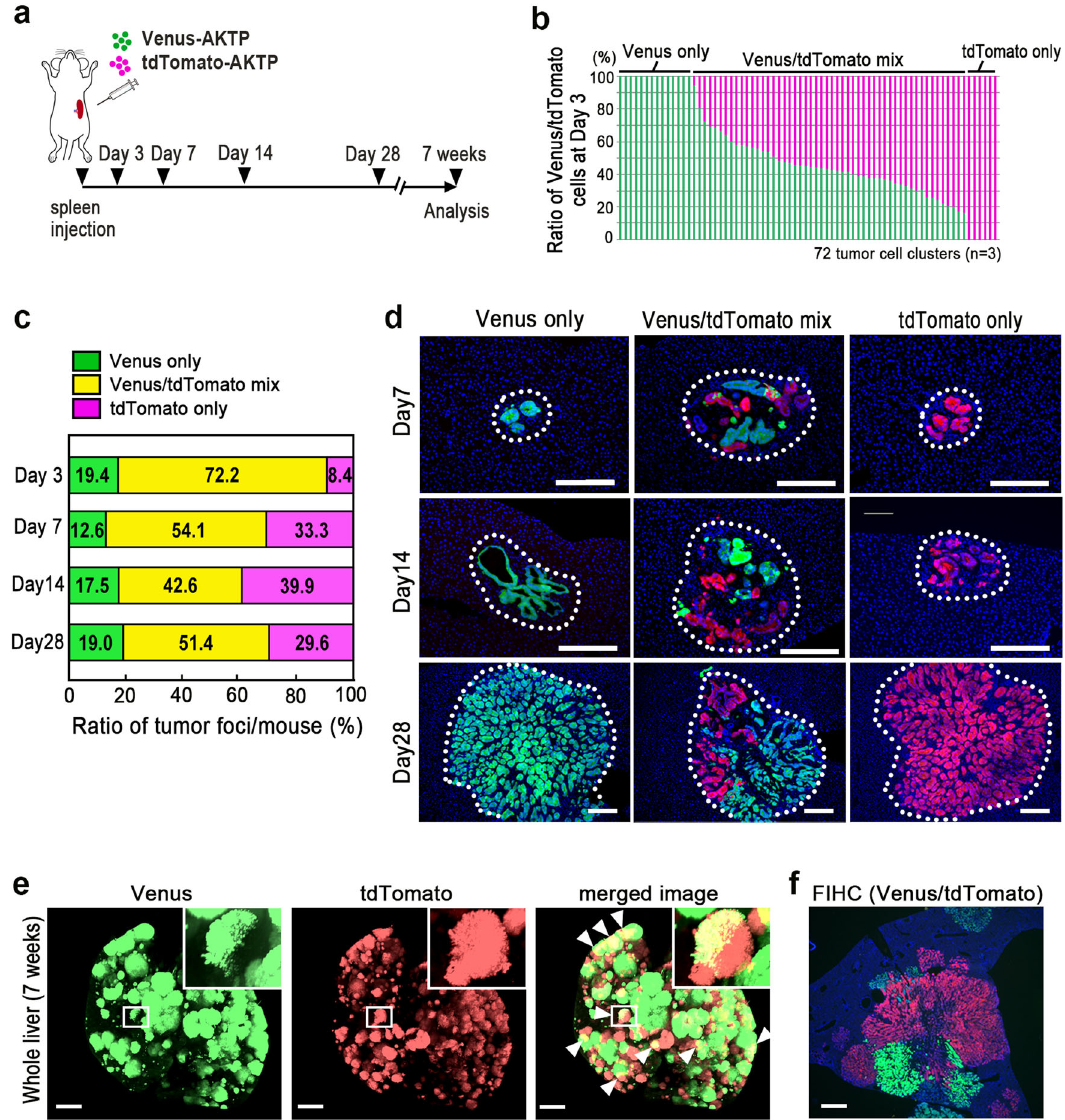
Fig. 1 The polyclonal origin of liver metastases in the spleen transplantation model. a Schematic illustration of the transplantation experiment. Venus- labeled AKTP cells (green) and tdTomato-labeled AKTP cells (red) were mixed and transplanted to the spleen. Liver tissues were examined at the indicated time points. b The ratios of Venus-AKTP (green bars) and tdTomato-AKTP cells (magenta bars) in 72 tumor cell clusters developed in n = 3 biologically independent mice at day 3 are indicated. c The ratios of metaplastic foci consisting of Venus-AKTP only (green), tdTomato-AKTP only (magenta), and a mixture of Venus- and tdTomato-AKTP cells (yellow) at each time point are indicated as a bar graph. d Representative photographs of the fl uorescent immunohistochemistry of tumor lesions consisting of Venus-AKTP only (left, green), tdTomato-AKTP only (right, red), and mixed Venus- and tdTomato-AKTP cells (center, green/red) at day 7 (top), day 14 (middle), and day 28 (bottom) after transplantation. Tumor foci are indicated by dotted lines. Bars, 200 μ m. e Representative photographs of fl uorescence imaging of the whole liver (CUBIC images) to detect Venus (488 nm) and tdTomato (590 nm), along with a merged image (left to right). Insets indicate enlarged images of the boxed areas. Arrowheads on the merged image indicate chimeric tumor lesions (yellow). Bars, 4 mm. f A representative photograph of the fl uorescent immunohistochemistry (FIHC) of Venus- and tdTomato-AKTP cells in the liver at 7 weeks after transplantation. Bar, 1 mm. The photographs in d , e , and f are representative images from n = 3 – 4 independent animals. Source data are provided as a Source Data (Supplementary Fig. 3b top A and B, respectively), suggesting that AKTP cells can generate metastases either via clonal dissemina- tion or serial seeding. When tdTomato-labeled AT or AP cells were injected into the portal vein as a secondary injection, all liver tumors consisted of Venus-labeled AKTP cells alone, and tdTomato-labeled AT and AP cells were not found by the his- tological examination. These results indicate that AT and AP cells need co-dissemination with AKTP cells for the development of polyclonal metastases rather than serial seeding.